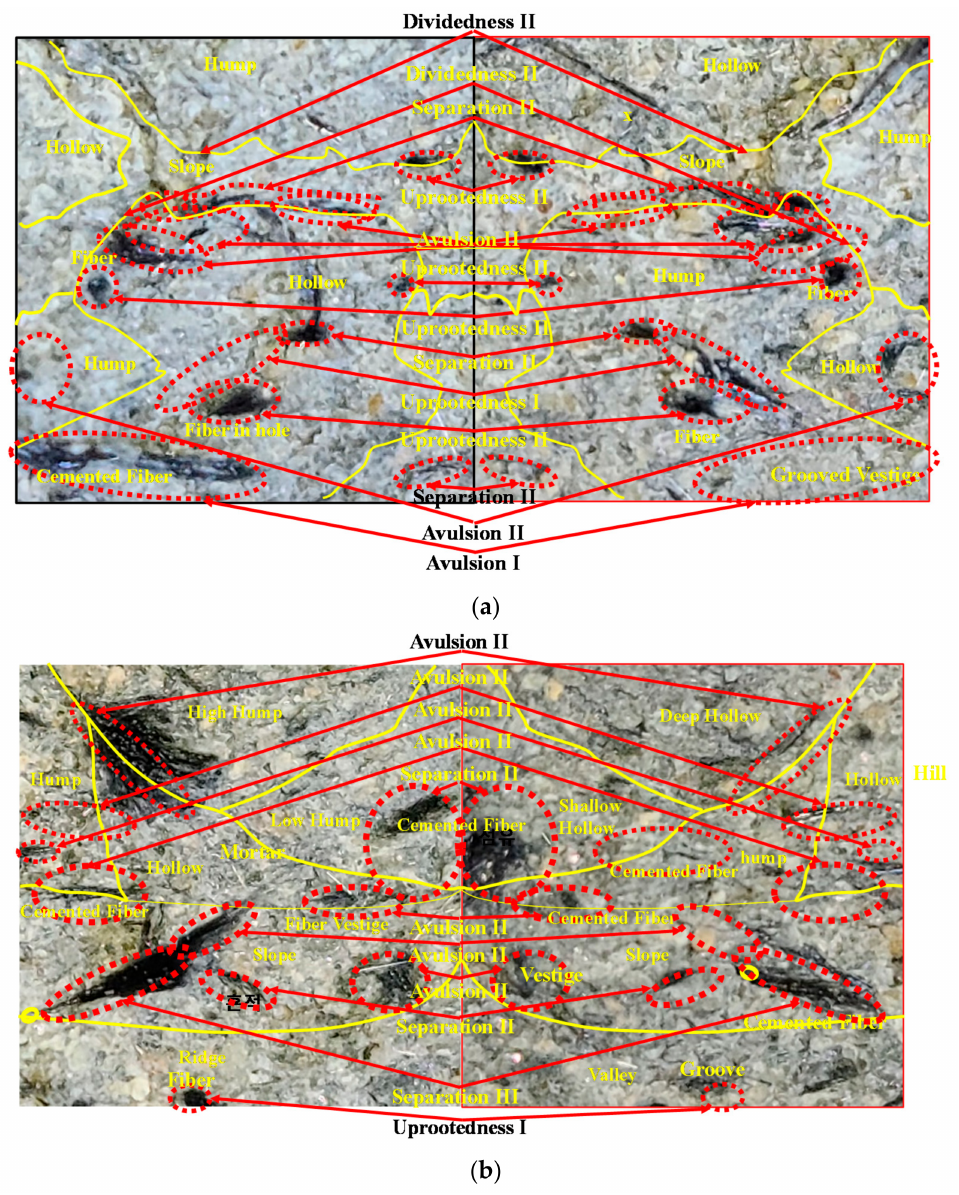
Figure 10. Fiber traces on the cracked surfaces of CF 1.5. ( a ) CF 1.5-1, ( b ) CF 1.5-2. The separation II in the bottom is on the slope. The area of CF 1.5-2 is mostly composed of cemented fiber clusters as written in the image. The area can be divided into six regions: hump, high hump, low hump, hollow, slope and valley. This indicates that there are five hollow and hump sets, i.e., five dividedness II in the images. There are 11 other